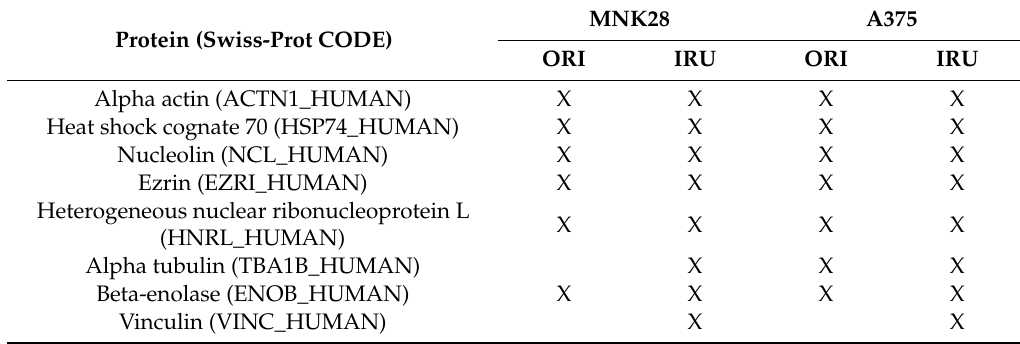
Table 1. Putative Ori and Iru targets identified in both the cancer cell lines by mass spectrometry-based Drug A ffi nity Responsive Target Stability (DARTS) experiments. Protein (Swiss-Prot CODE)